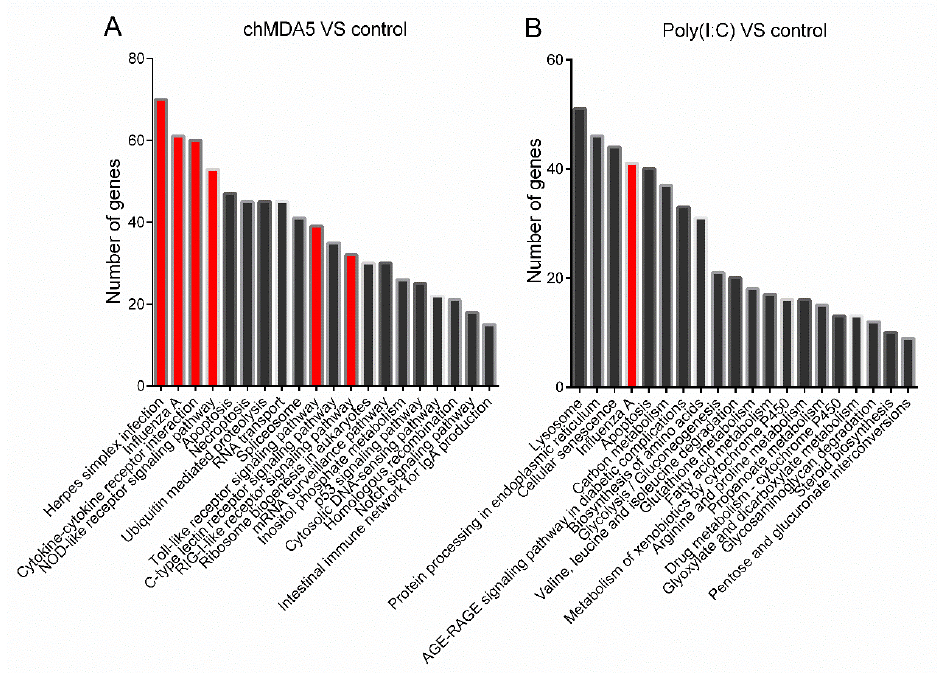
Figure 3. KEGG analysis of the DEGs. The top 20 KEGG pathways were significantly enriched ( p < 0.05) in chMDA5 ( A ) and poly(I:C) ( B ) group. The red columns indicate the pathways that are associated with innate immune response. x -axis indicates different pathways, and y -axis indicates DEG numbers in the enriched KEGG pathways.